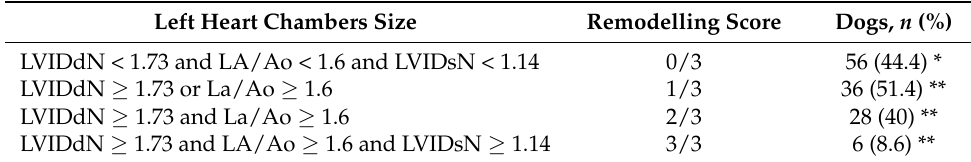
Table 4. Results of the remodelling score classification. Left Heart Chambers Size Remodelling Score Dogs, n (%) LVIDdN < 1.73 and LA/Ao < 1.6 and LVIDsN < 1.14 0/3 56 (44.4) * LVIDdN ≥ 1.73 or La/Ao ≥ 1.6 1/3 36 (51.4) ** LVIDdN ≥ 1.73 and La/Ao ≥ 1.6 2/3 28 (40) ** LVIDdN ≥ 1.73 and LA/Ao ≥ 1.6 and LVIDsN ≥ 1.14 3/3 6 (8.6)